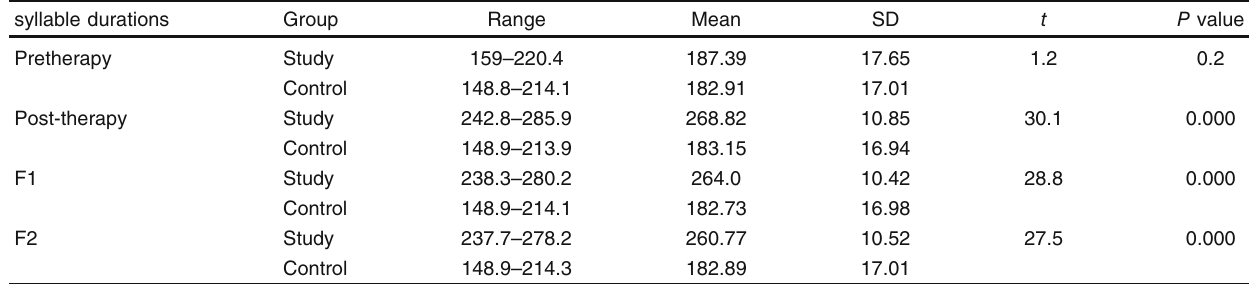
Table 9 Comparison between the study group and the control group as regards syllable